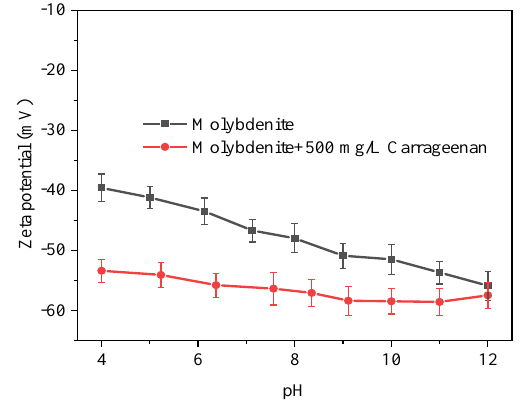
Figure 6. Zeta potential of molybdenite as a function of pH.